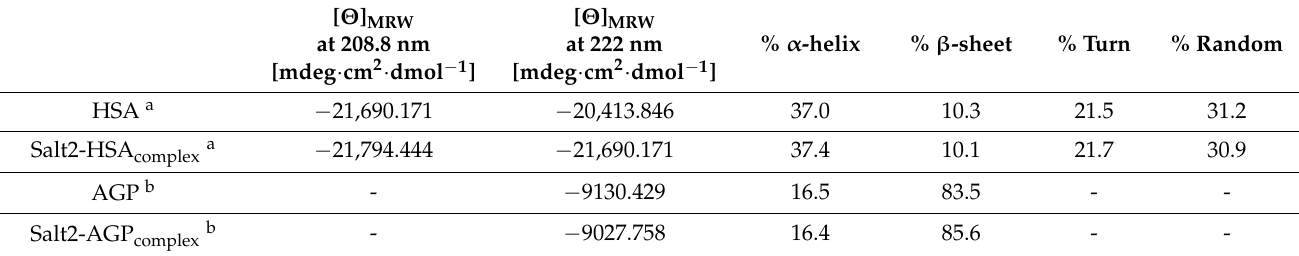
Table 6. The mean residue ellipticity [ Θ MRW ] and the percentage (%) content of the secondary structure elements of HSA and AGP based on the Yang’s and Reed’s reference model,